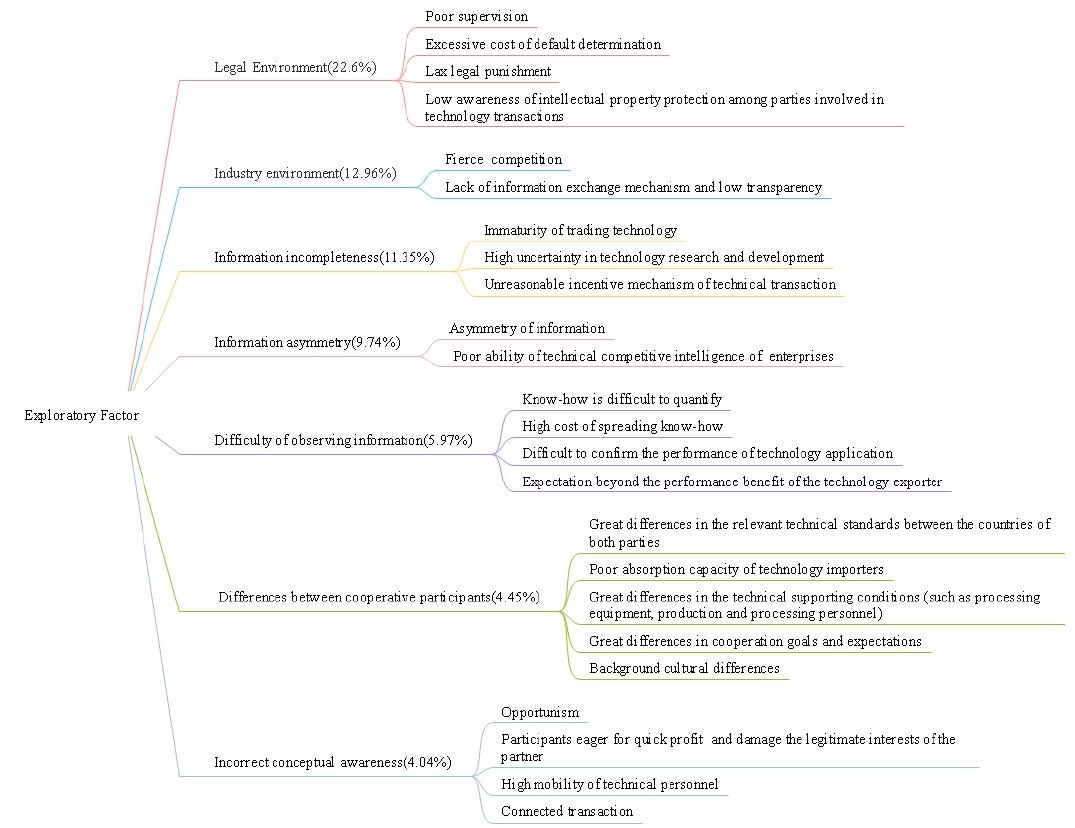
Figure 2. Causal factors of occupational ethics risk.